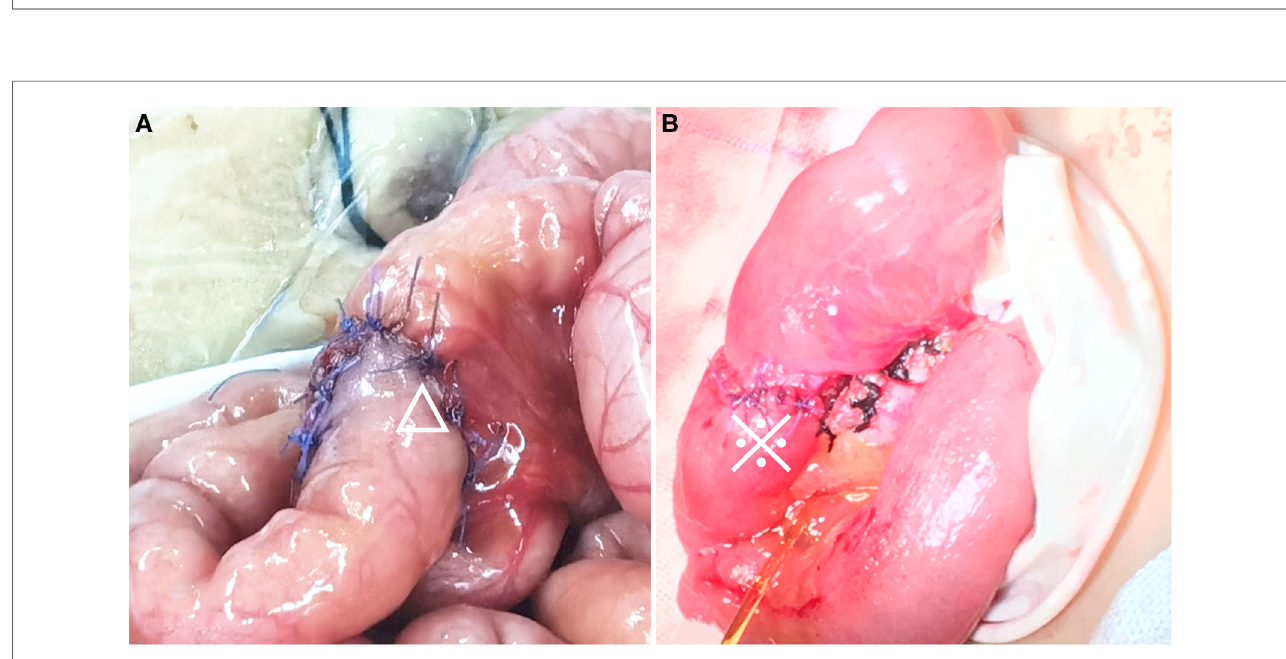
FIGURE 2 A 5-month-old boy with generalized peritonitis and septic shock caused by a perforated terminal ileum due to a congenital fi brotic band compression. ( A ) Perforation (small Δ ) and necrosis (arrow) at the terminal ileum; ( B ) completion of primary anastomosis (large Δ ) using the asymmetric fi gure-of-eight suture technique.